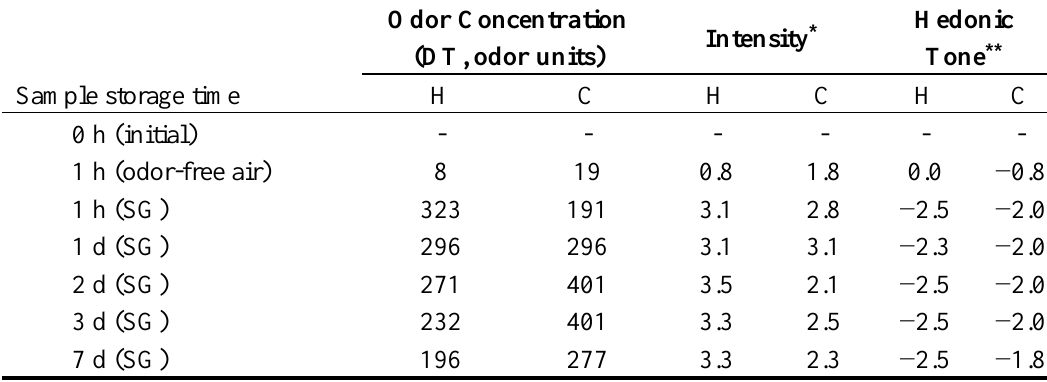
Table 6. Laboratory detection thresholds (DT) as measured by trained human panelists by dynamic triangular forced-choice olfactometry using homemade (H) and commercial (C) Tedlar PVF bags filled with the VOC standard gas (SG)